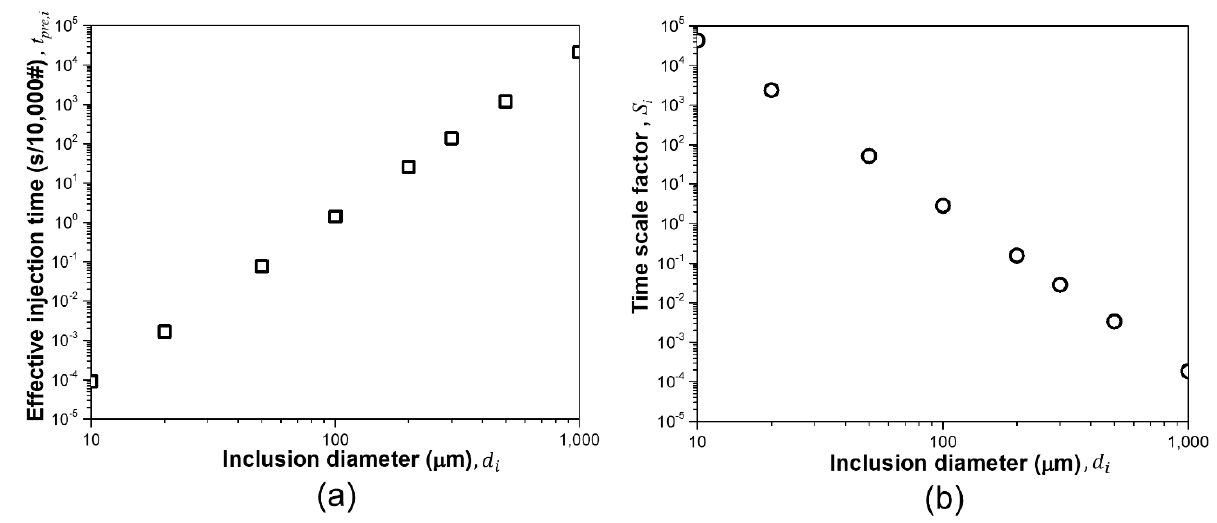
Figure 12. Particle capture locations in the steel slab sample, based on UT measurements (side view).